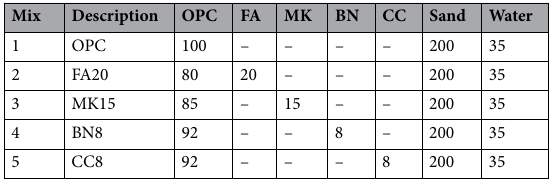
Table 3. Mixture design of mortars by mass